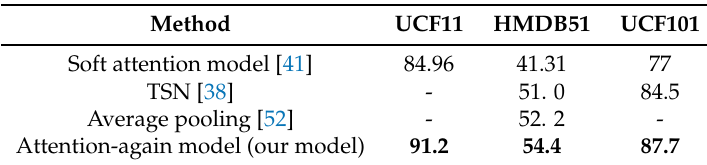
Table 4. Comparison with state of the art methods, the result from RGB data only. The bold text represents the best result.